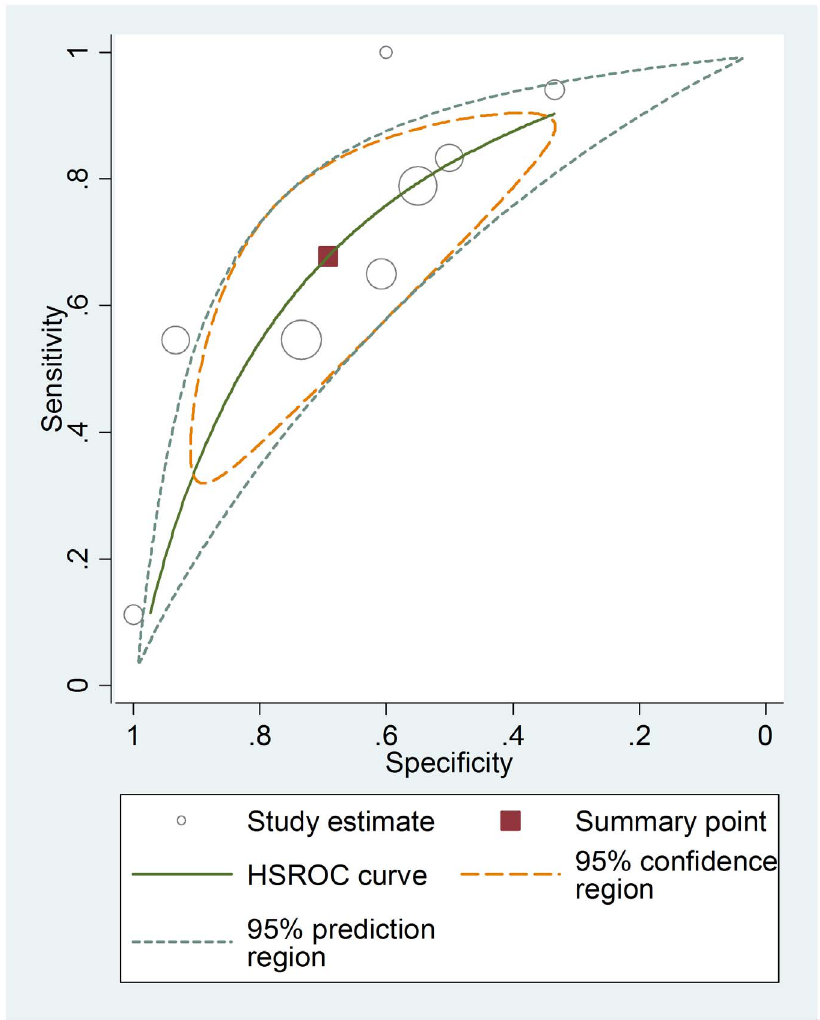
Figure 12. The hierarchical summary receiver operating characteristic (HSROC) curves of NSE to predict unfavourable outcome in patients with traumatic brain